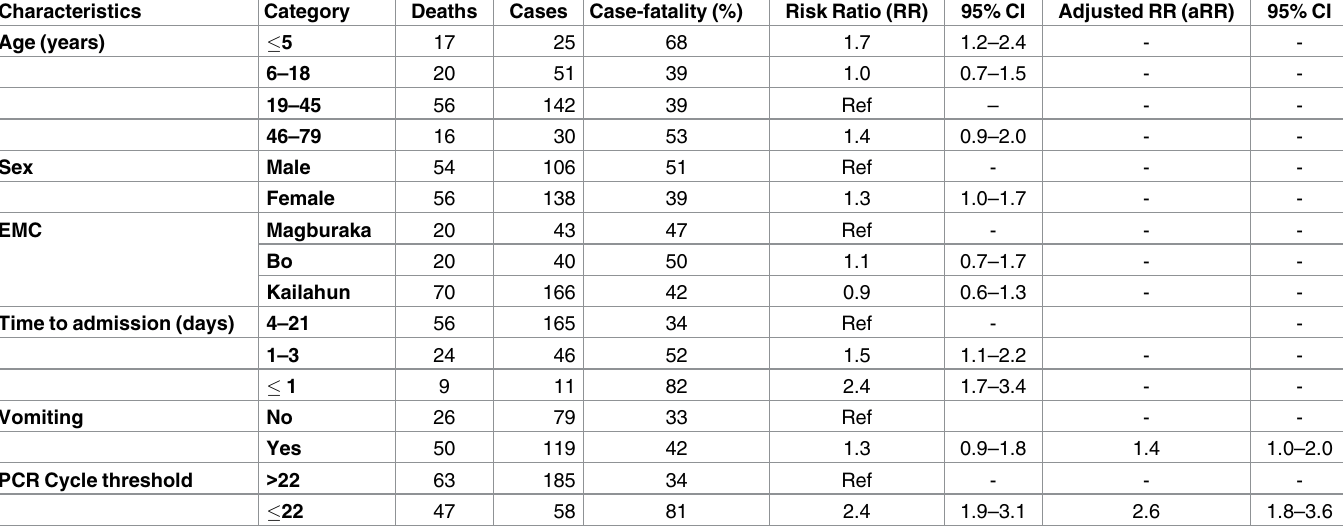
Table 4. Case fatality, (N = 110) according to selectedcharacteristics, Tonkolili, Sierra Leone, 2014–2015. Characteristics